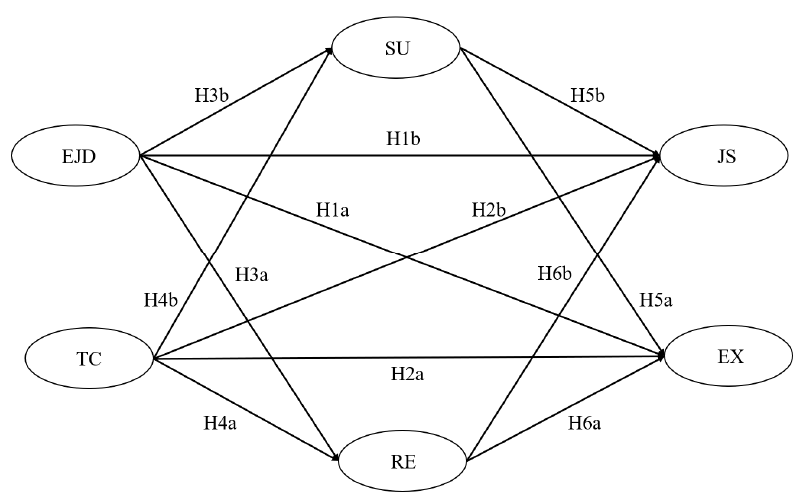
Figure 1. The hypothetical model. Note: EJD = emotional job demands, TC = trust in colleagues, RE = reappraisal, SU = suppression, EX = emotional exhaustion, JS = job satisfaction.